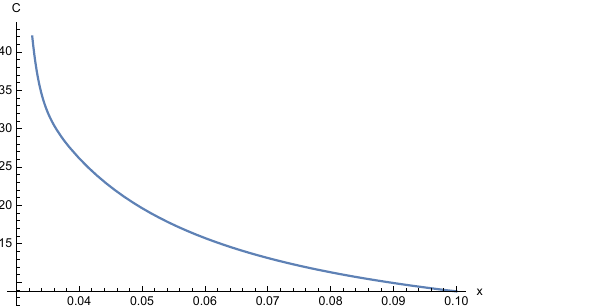
Figure 6. Plot of C ( x ) versus x . Here, x = β / R 1 , R 0 = 1, G = m = M = 1. The binding energy increases as β grows and the mean energy U is negative. Thus, the specific heat = − β 2 dU Notably enough, it tends to obey the third law in a classical scenario, as bound by